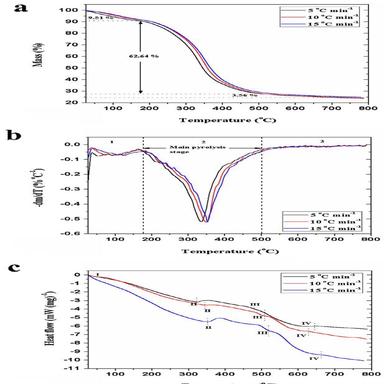
TGA-DTG-DSC curves of slow pyrolysis process of Poplar fluff at different heating rates.